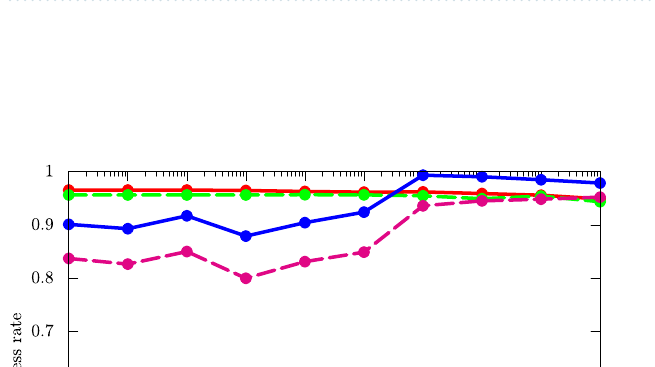
Figure 4. Performance dependence of the UKM on r , which is the coefficient of the second term in the right-hand side of Eq. (20) for the cancer dataset (0 or 1). We use complex matrices for the initial input and set θ bias = 0 . We put r = 0.010 and K = 30 . We repeat the CG iteration for Eq. (20) 10 times in each step of the method of SOC.